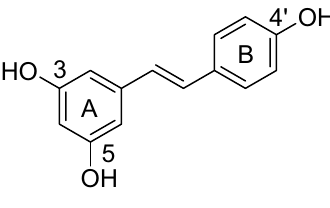
Figure 1. Structure of resveratrol.